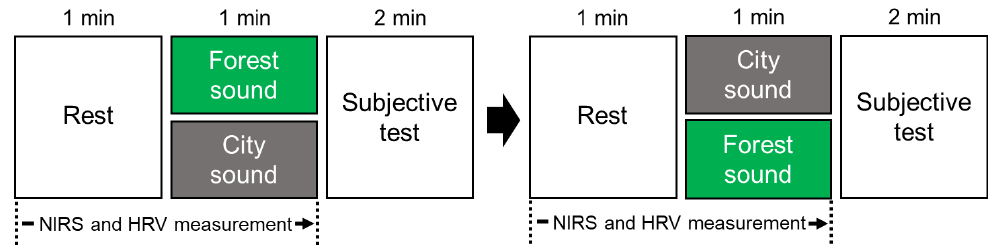
Figure 2. Measurement protocol. The order of the forest and city sounds was counterbalanced to avoid any order effects. NIRS: near-infrared spectroscopy; HRV: heart rate variability.